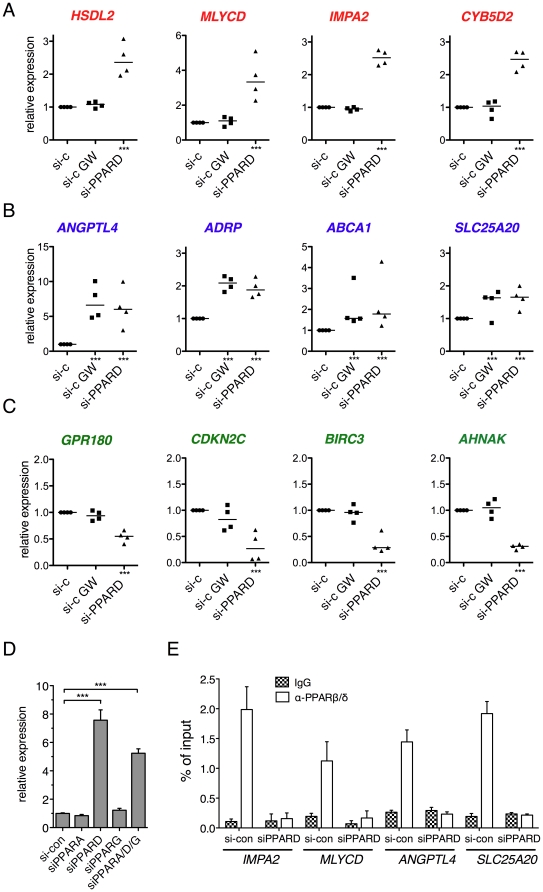
Identification of different types of transcriptional responses to PPARβ/δ depletion and ligands.(A–C) Differential responses to GW501516 and PPARD siRNA of PPARβ/δ target genes, classified as type I (A), type II (B) and type III (C) responses. WPMY-1 cells were treated as indicated and analyzed as in Figure 1. Data from four biological replicates are shown. Individual data points represent the average of 3 technical replicates. Horizontal lines indicate the median of 4 biological replicates. (D) PPAR subtype-specific repression of the ANGPTL4 gene by PPARβ/δ. WPMY-1 cells were transfected with PPARA, PPARG or PPARD siRNA pools, or a combination of all three pools (triple knock-down), and relative ANGPTL4 mRNA levels were measured by RT-qPCR. The efficiencies and subtype specificities of the siRNA pools are shown in Figure S4. (E) Effect of PPARD siRNA treatment on PPARβ/δ recruitment to the IMPA2, MLYCD, ANGPTL4, SLC25A20, BIRC3 and GPR180 genes.